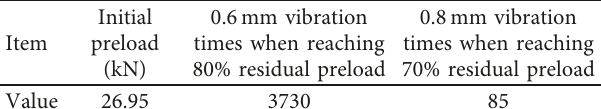
Figure 10: Variable amplitude test loosening curve “from small to big.” Table 6: Variable amplitude test results of “from big to small.”